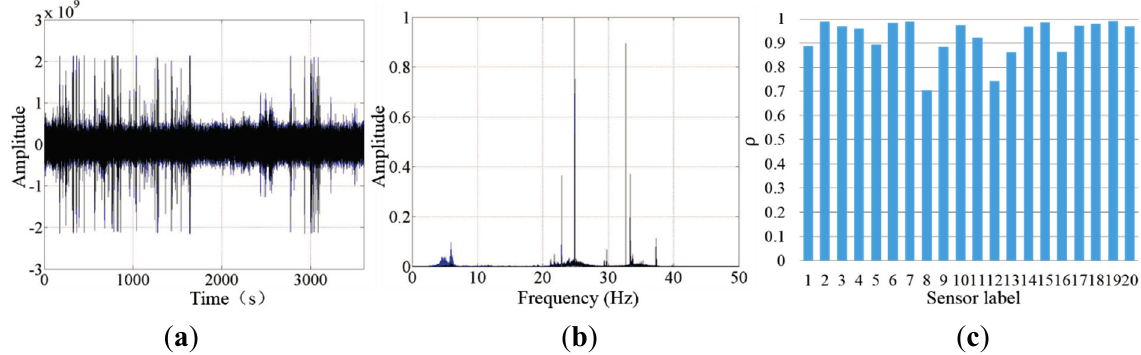
Figure 6. Cableless geophone correlation testing results: ( a ) amplitude time series collected by 21 sensors; ( b ) power spectral densities of the signals; and ( c ) correlation coefficients between different